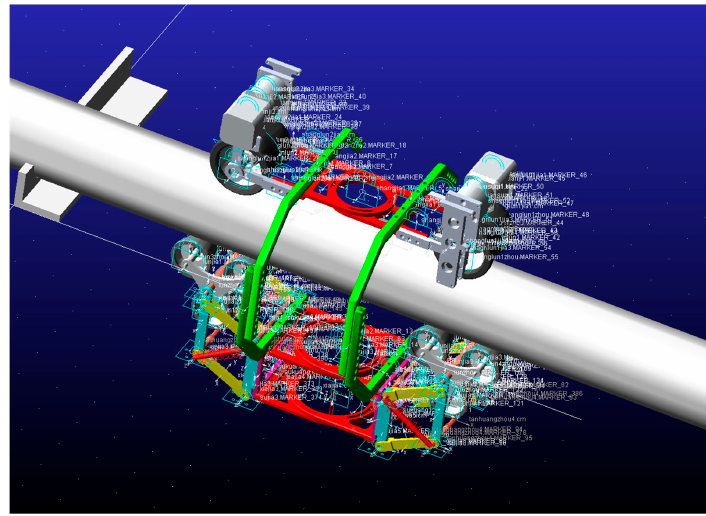
Figure 9. Virtual model simulation analysis.